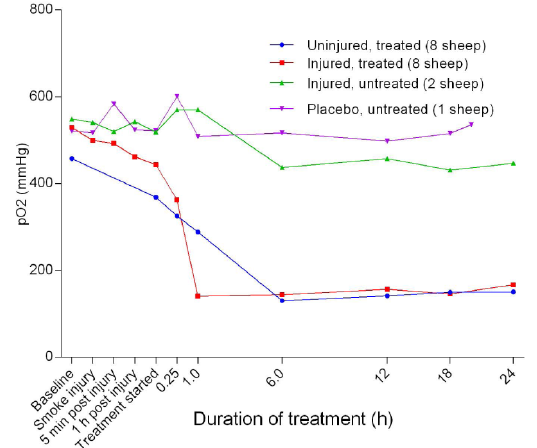
Figure 7. Arterial oxygen tension (pO error bars shown) in smoke and non-smoke injured sheep that received extracorporeal life support as compared to that in untreated controls. Error bars have been omitted for clarity.